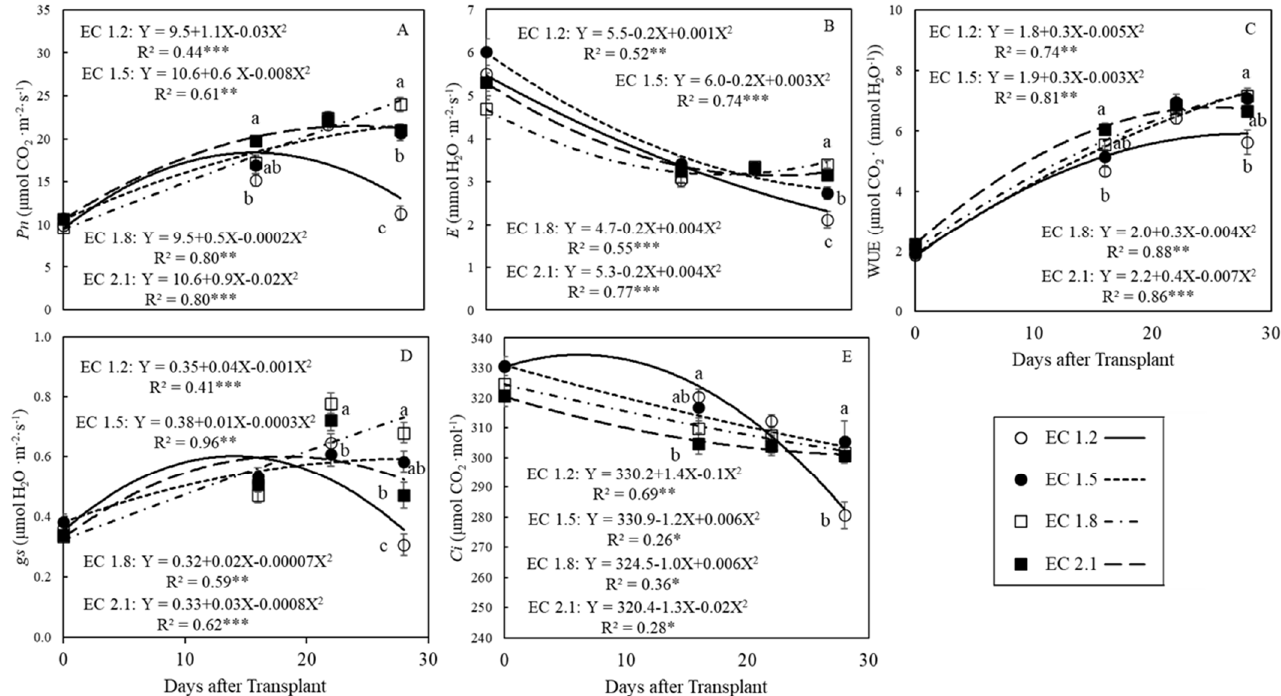
Figure 6. Effect of electrical conductivity (EC) of nutrient solution on ( A ) the net photosynthetic rate, ( B ) transpiration rate, ( C ) water use efficiency, ( D ) stomata conductance, and ( E ) intracellular CO 2 concentration of arugula on the day before transplant, and 16th, 22nd, and 28th days after transplanting into a nutrient-film technique hydroponic system containing nutrient solutions with EC of 1.2, 1.5, 1.8, or 2.1 dS · m − 1 . Data points with different letters are significantly different according to Tukey’s test ( α = 0.05). Error bars represent the standard error ( n = 16). *, ** or *** indicate significance at P of 0.05, 0.01 or 0.001, respectively.